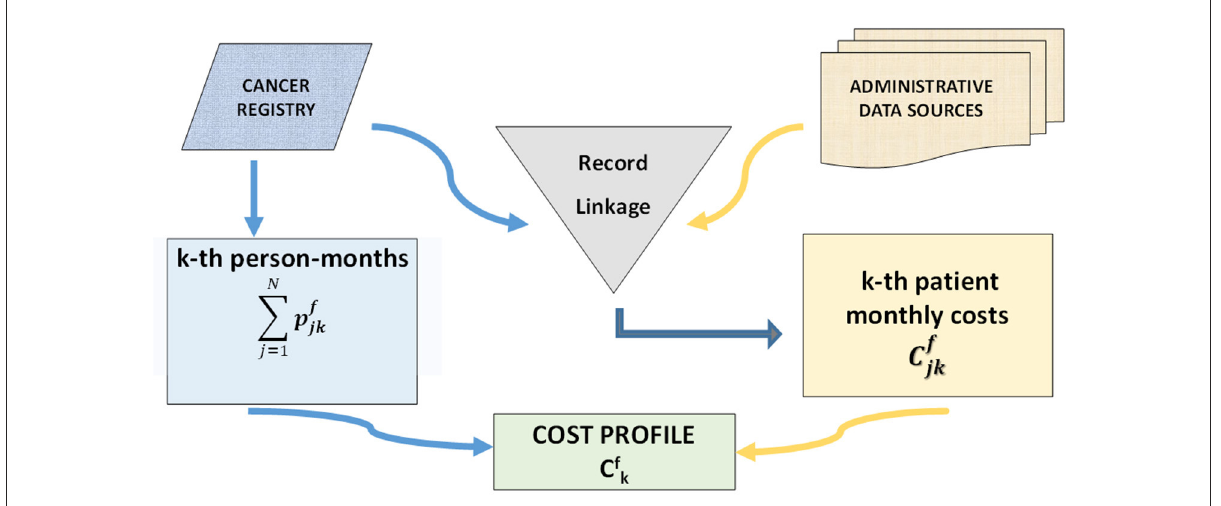
FIGURE2 Flow-chart of the main steps of the cost estimation